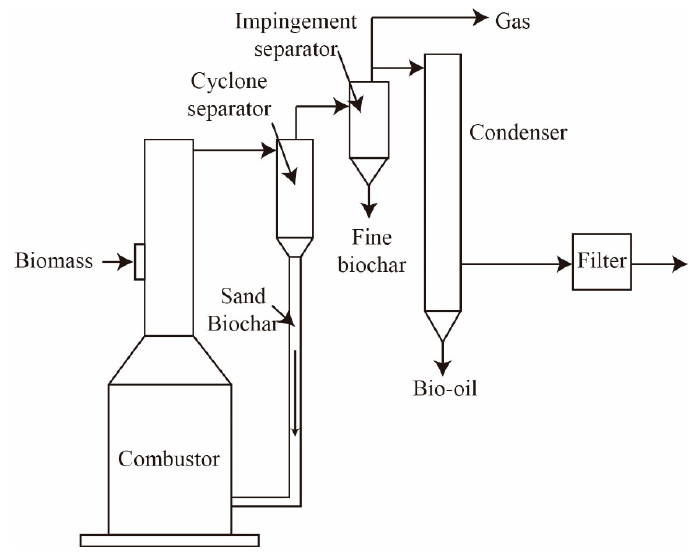
Figure 7. Schematic for the circulating fluidized bed.